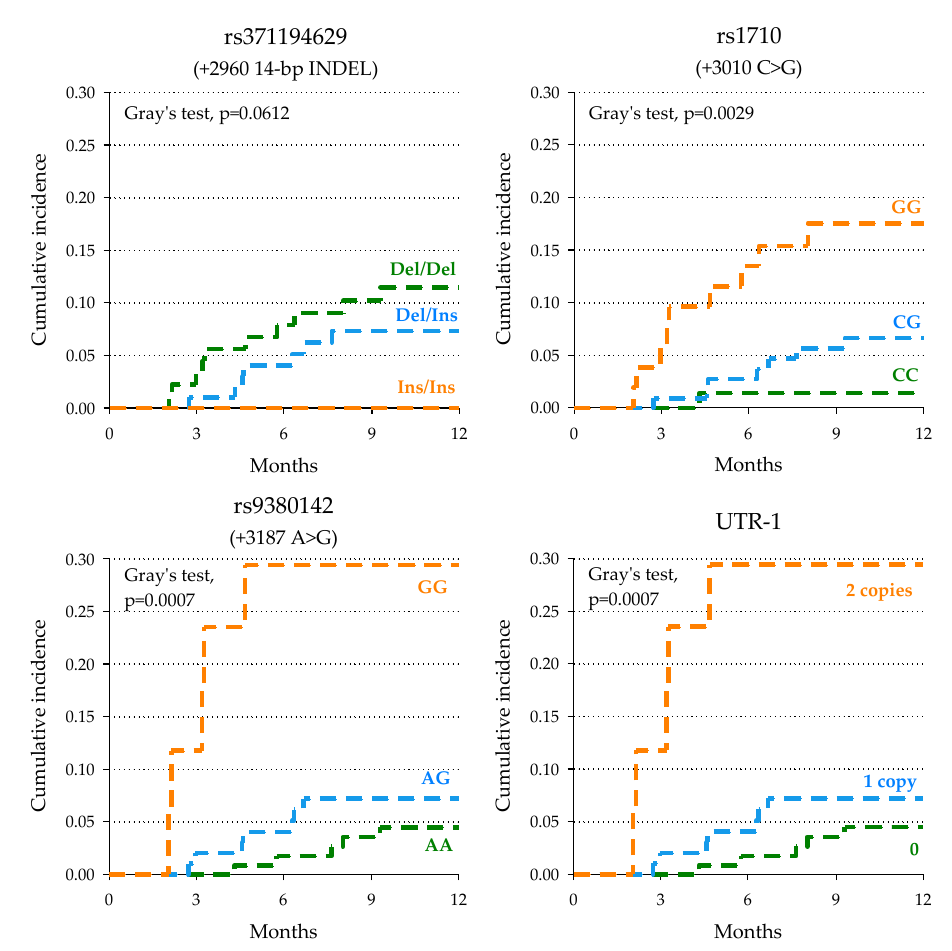
Associations with p -value < 0.05 are evidenced in bold. a Estimated from unconditional logistic regression model, adjusting for gender, age, site, stage at diagnosis, radical surgery, adjuvant treatment, and number of metastatic sites. b Corrected for multiple comparisons according to the Benjamini–Hochberg method.